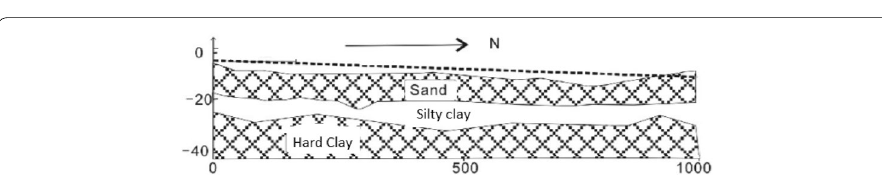
Fig. 9 Conceptual cross-section of the modeled